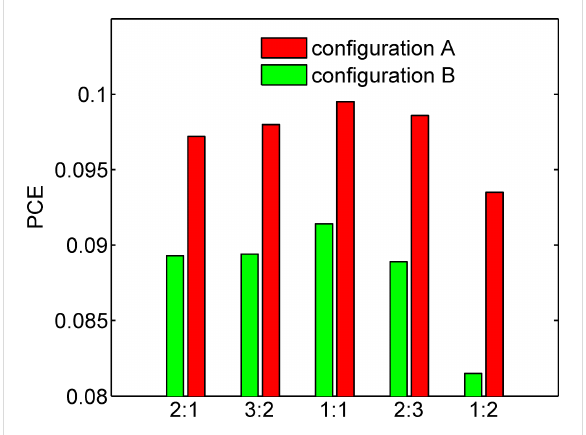
Figure 10: Optimal PCE values for different configurations and differ- ent D/A weight ratios in the P3HT/PCBM blend.